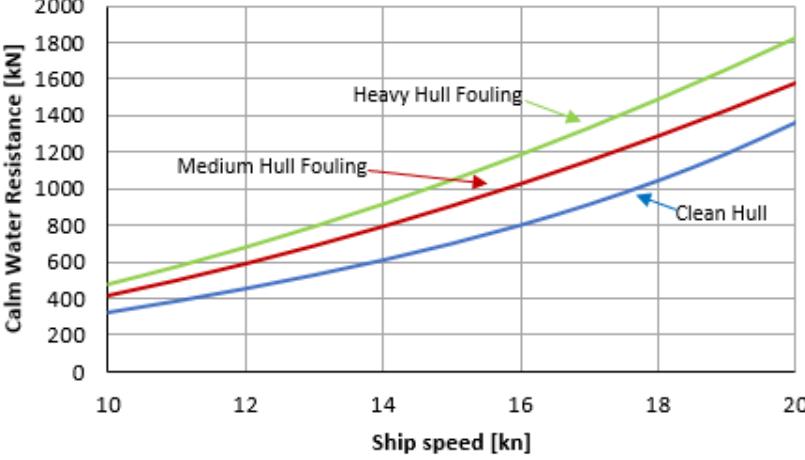
Figure 4. Impact of fouling on calm water resistance curves.